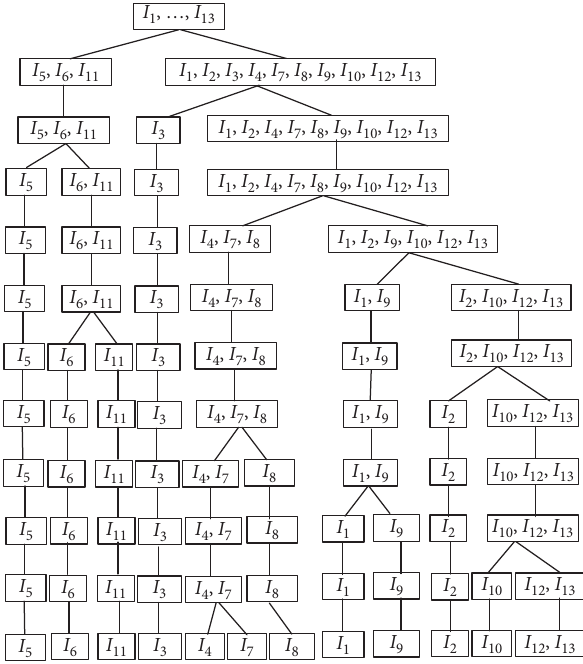
Figure 3: Cluster analysis of average insertion of 99 points.